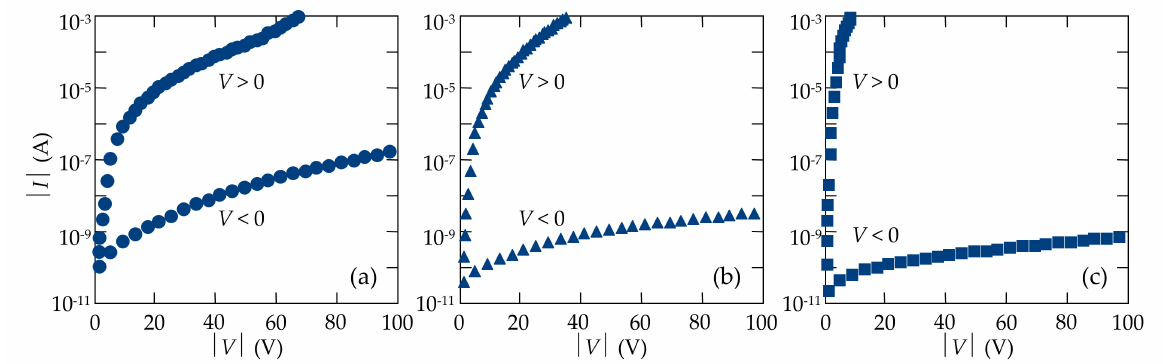
Figure 8. I-V characteristics of the In/CdTe/Au diode structures in semi-logarithmic coordinates ( a ) before and ( b , c ) after irradiation from the In electrode side by nanosecond pulses of a KrF excimer laser with energy densities of ( b ) 90 J/cm 2 and ( c ) 120 J/cm 2